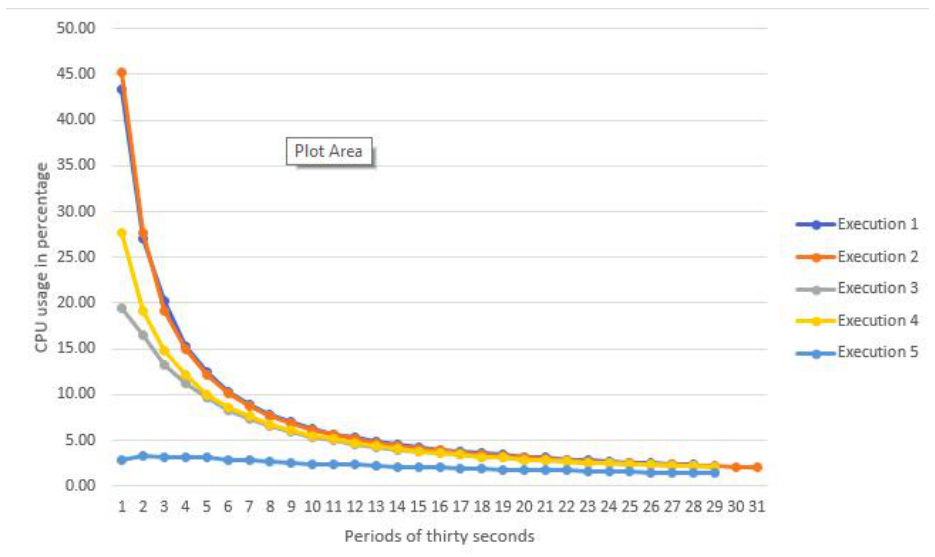
Figure 16. Evolution of the CPU usage over a period of